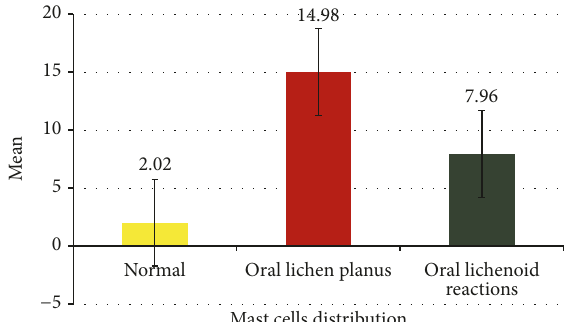
Figure 5: Photomicrograph of the section shows intact mast cells in oral lichen planus (Toluidine Blue 40x). The arrows refer to intact mast cells in oral lichen planus.